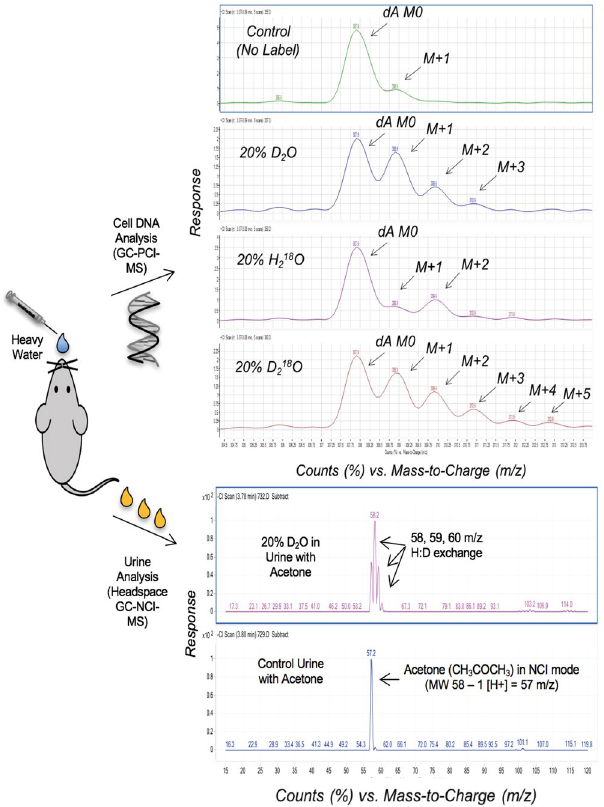
Figure 8. Mass spectrometry isotopic signatures (normalized) for stable heavy water in mouse cellular DNA and total body water (urine). After dosing with stable heavy water (e.g. D 2 O), DNA deoxyadenosine (dA) enrichments can be measured using GC-PCI-MS, with total body water measurements using headspace-GC-